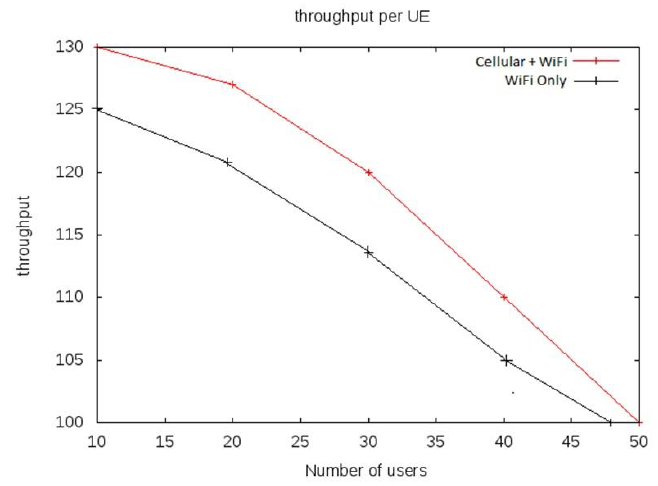
Figure 3. Throughput vs. number of